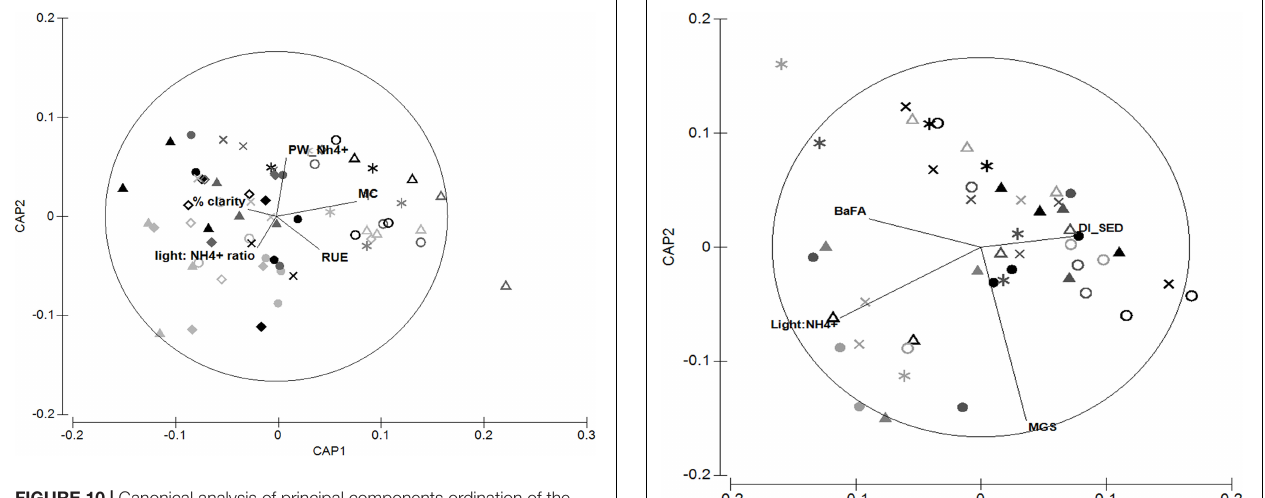
FIGURE 10 | Canonical analysis of principal components ordination of the quantity and quality indicators of the MPB and their relationship to environmental variables. Canonical axis 1 ( δ 2 = 0.41) and canonical axis 2 ( δ 2 = 0.15). PW NH4 + - porewater NH 4 + concentration (0 – 2 cm depth). MC – mud content of the bed. RUE – resource use efficiency of the MPB (chl a:NH 4 + ratio).Light:NH 4 + ratio – The ratio between high-tide light and porewater NH 4 + concentration.% clarity – The proportion of low tide light that reaches the PAR sensor during high tide, used as a proxy of turbidity. Symbols represent sites: Solid triangle – MH1; solid diamond – MH2; solid circle – MH3; open triangle – MK; open circle – WG; open diamond – WR1; star – WR2; cross – WR3. Colors represent nitrogen treatments: Light gray – control; dark gray – medium; black – high treated plots.